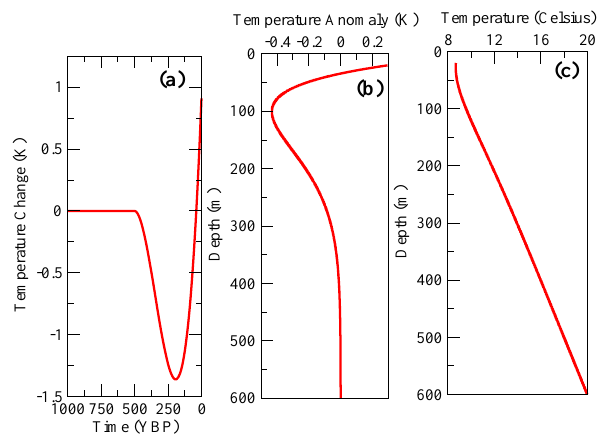
Fig. 1. (a) Synthetic ground surface temperature function used to generate the synthetic temperature-depth anomaly shown in (b) . The simulated temperature log (c) was constructed by adding (b) to an equilibrium surface temperature of 8.0 ◦ C, and a steady-state geothermal gradient of 20Kkm − 1